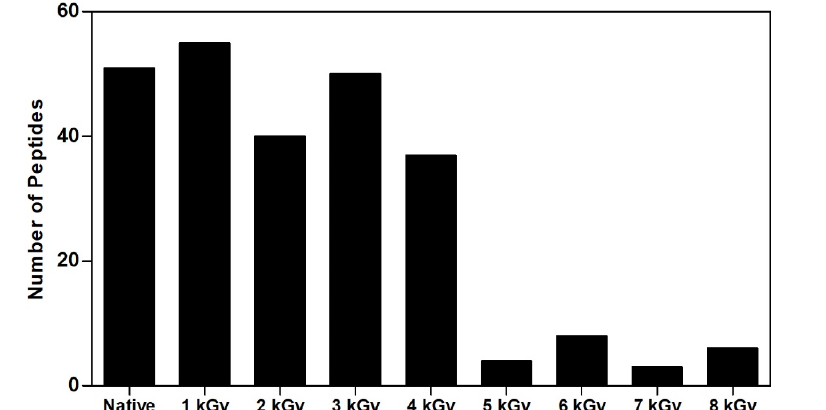
Figure 3. Determination of peptide number nTeNT and iTeNT with 1 kGy, 2 kGy, 3 kGy, 4 kGy, 5 kGy, 6 kGy, 7 kGy and 8 kGy by liquid chromatography-mass spectrometry (LC-MS), using an electrospray-ion trap-time of flight (ESI-IT-TOF) system coupled to a binary ultra-fast liquid chromatography system (UFLC) (20 A Prominence, ShimadzuKyoto,